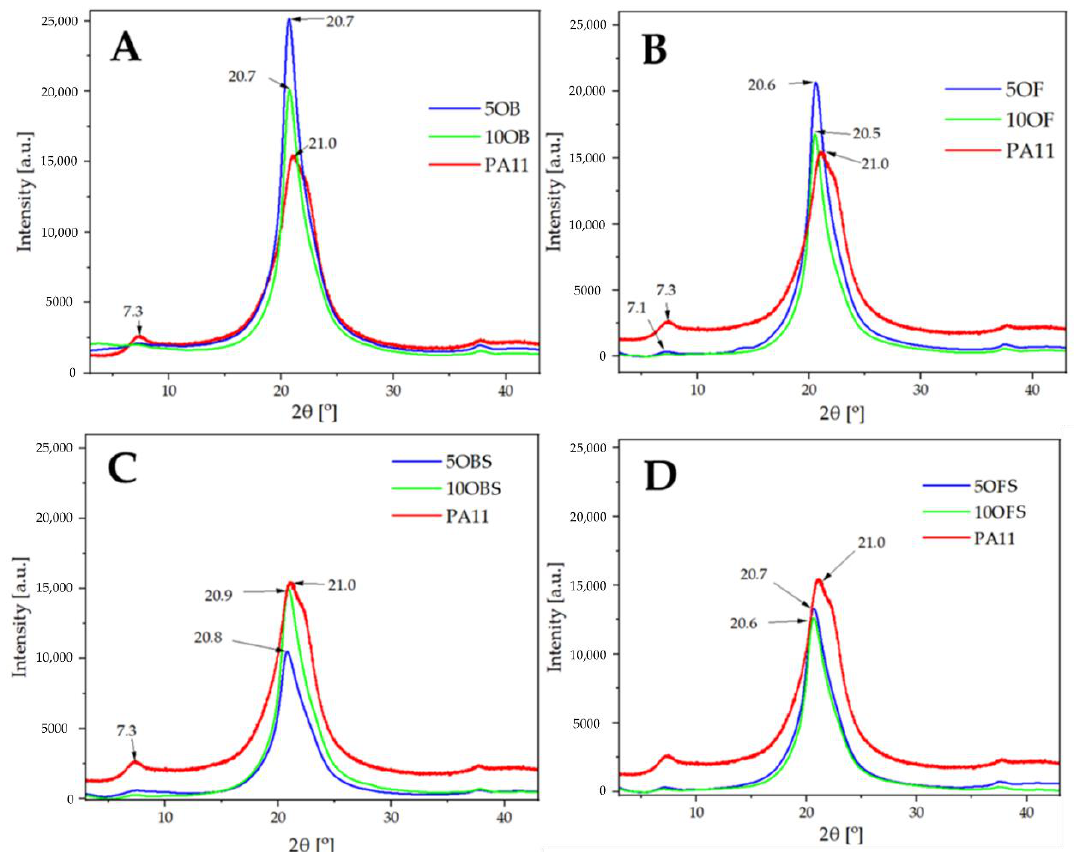
Figure 5. XRD PA11/diatoms with and without silane APTES; ( A )—samples with base diatomite; ( B )—samples with fractionated diatomite and APTES; ( C )—samples with base diatomite; ( D )—samples with fractionated diatomite and APTES.